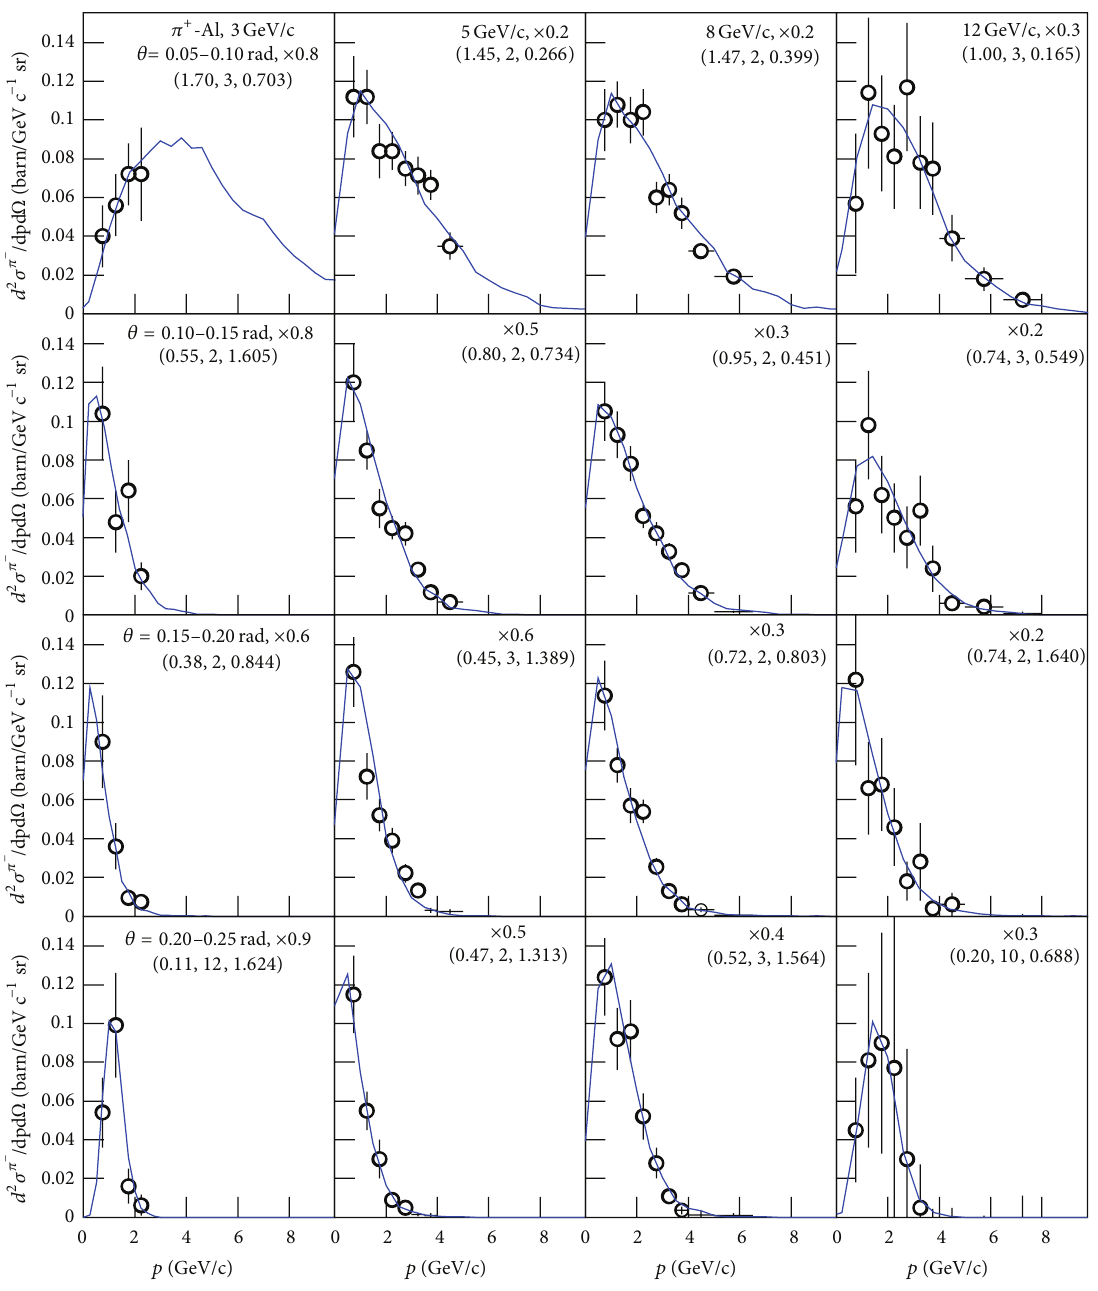
Figure 12: The same as Figure 1, but showing the results for 𝜋 − production cross sections in 𝜋 + -Al interactions.